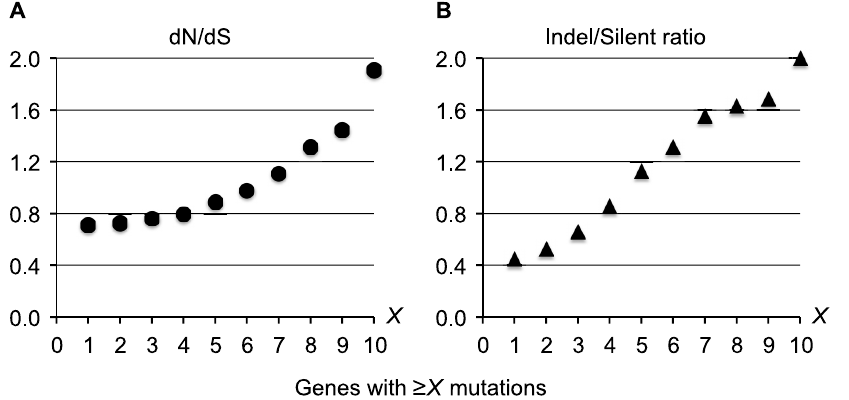
Figure 6. Increased pressures of selection for mutations in the top most mutated genes. Measures of the selection pressures were plotted for genes acquiring $ X mutations during the evolution of the DK2 lineage. Plot A shows the dN/dS ratio, and plot B shows the ratio of indels relative to silent SNPs.